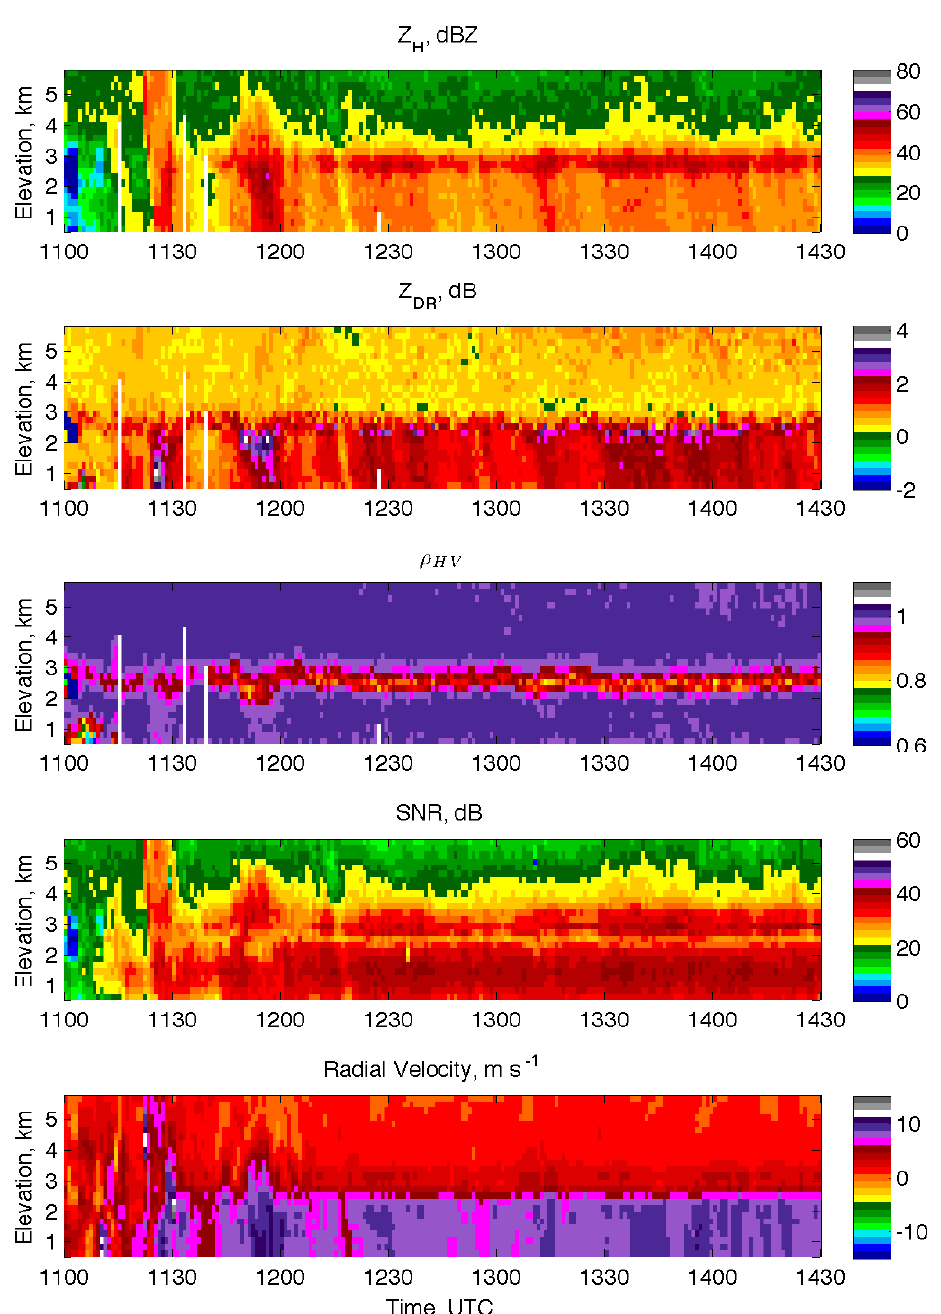
Fig. 2. Time-height cross sections of data collected during 11 March 2007 squall line event. Elevation is in kilometers above ground level, time is in UTC. Presented data fields are (from top to bottom): KOUN Z H (dBZ), KOUN Z DR (dB), KOUN ρ HV , ARRC profiler signal-to-noise ratio (dB), and ARRC profiler mean vertical velocity (ms − 1